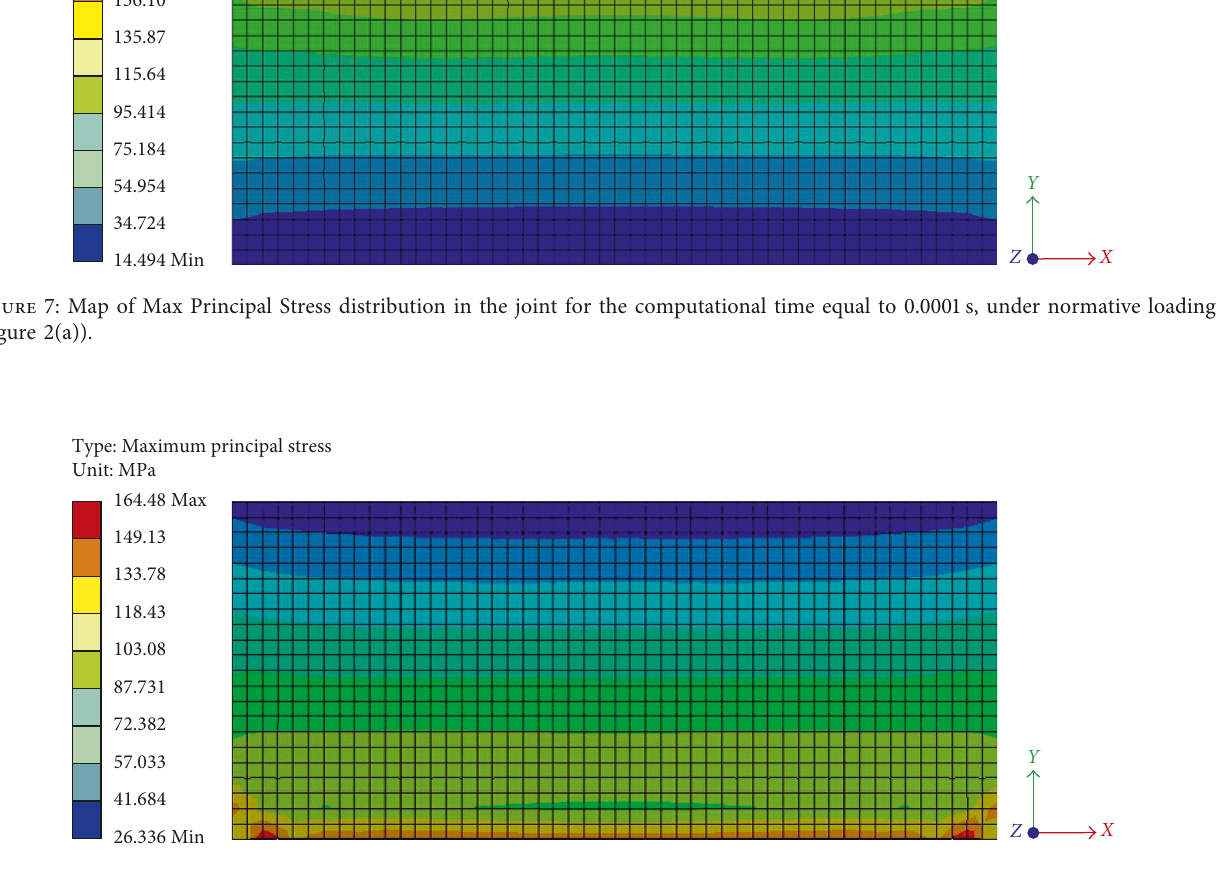
Figure 8: Map of Max Principal Stress distribution in the joint for the computational time equal to 0.0001s, under nonnormative loading (Figure